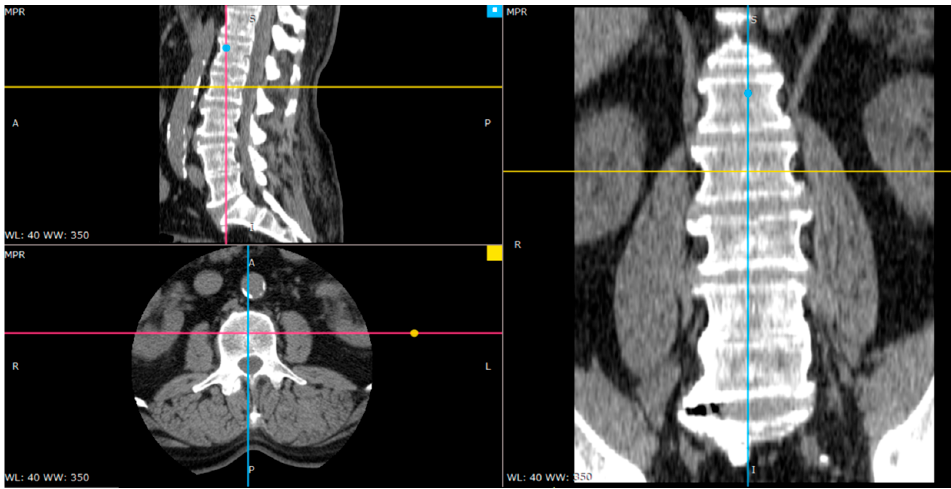
Figure 1. The arrangement of the axis in the center of one of the vertebrae (image in three projections). The images on the same vertebra level were selected for soft tissue and bone recon- struction. Since the thickness of layers for bone reconstruction was halved, every other layer of a given vertebra cross-section was analyzed. The images selected for further studies were saved in BMP format and converted from 24-bit RGB to 8-bit greyscale. The ex- traction of the regions of interest (ROI) was performed manually (Figure 2). The size of the extracted samples was selected to use the textured surface, potentially containing the information in the image of the transverse vertebra section, to the maximum extent. This resulted in samples with a size of 50 × 50 pixels (Figure 3).